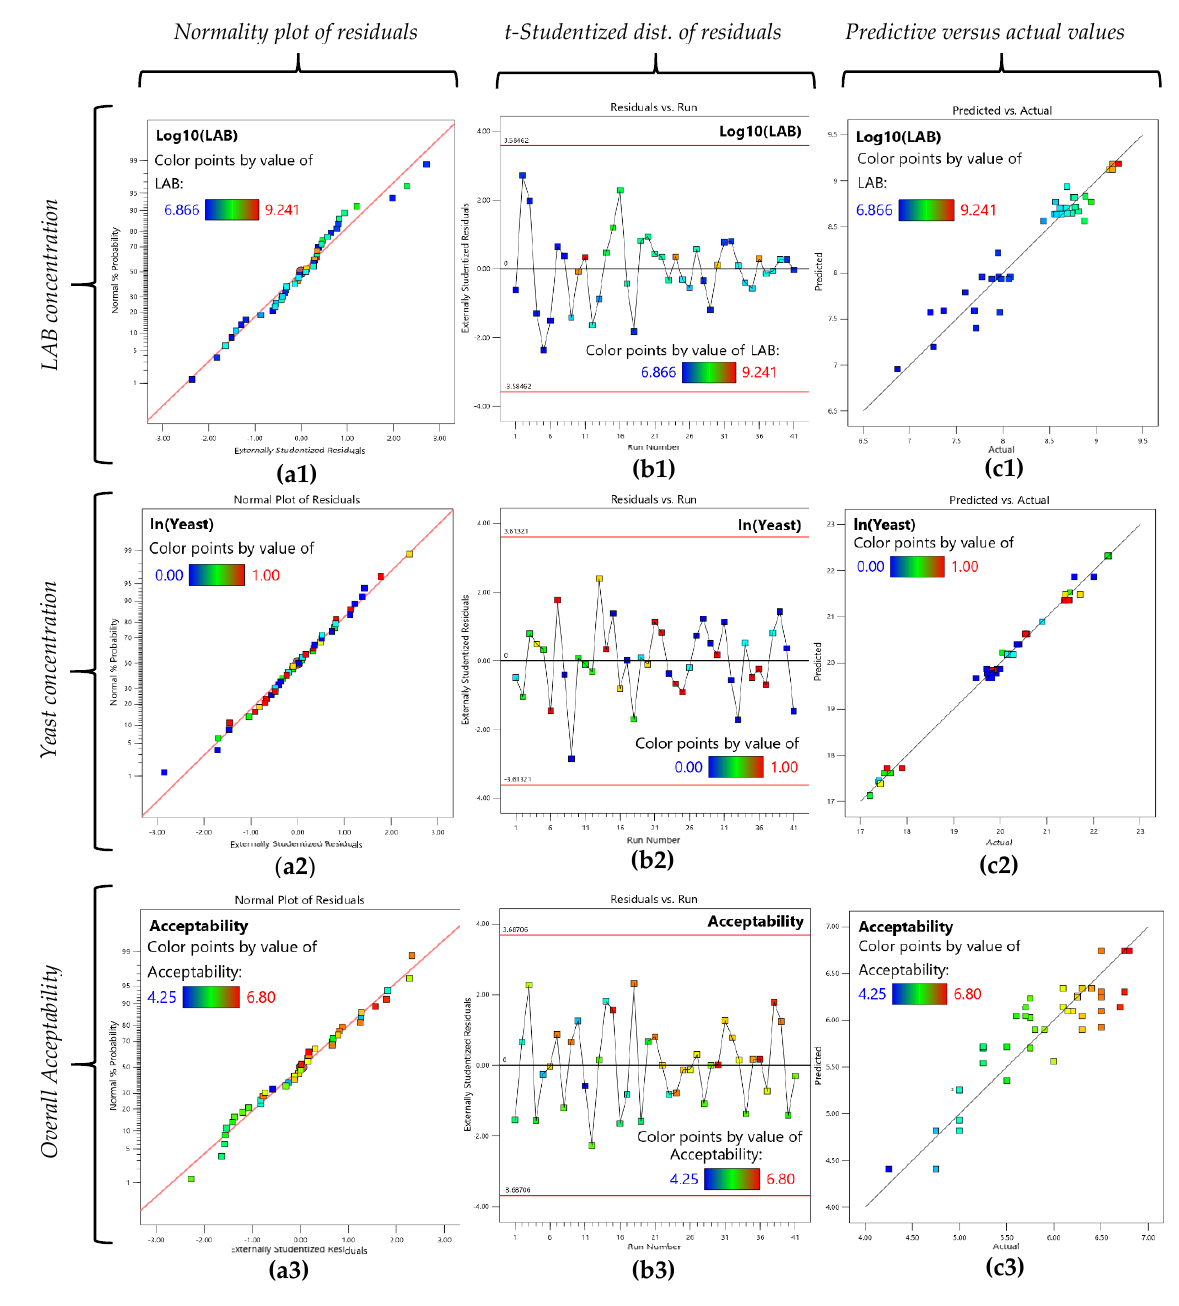
Figure 1. Analysis of the models of the responses for LAB concentration (upper part, a1 – c1 ); yeast concentration (middle part, a2 – c2 ); and overall acceptability (lower part, a3 – c3 ). ( a1 – a3 ) Normality plot of the residuals for the models shown in Equations (1) to (3), respectively. ( b1 – b3 ) Student’s t external distribution of the residuals. ( c1 – c3 ) Correspondence between the real values of the responses with the values obtained with the models shown in Equations from (1) to (3),